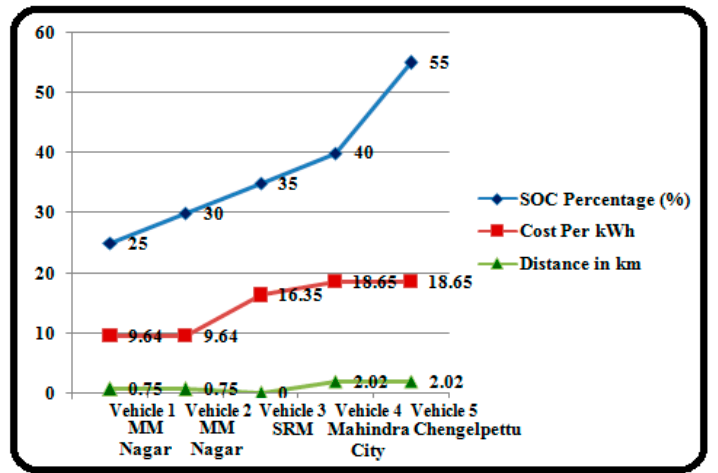
Figure 16. EVs Charging Slot Reservation Chart.